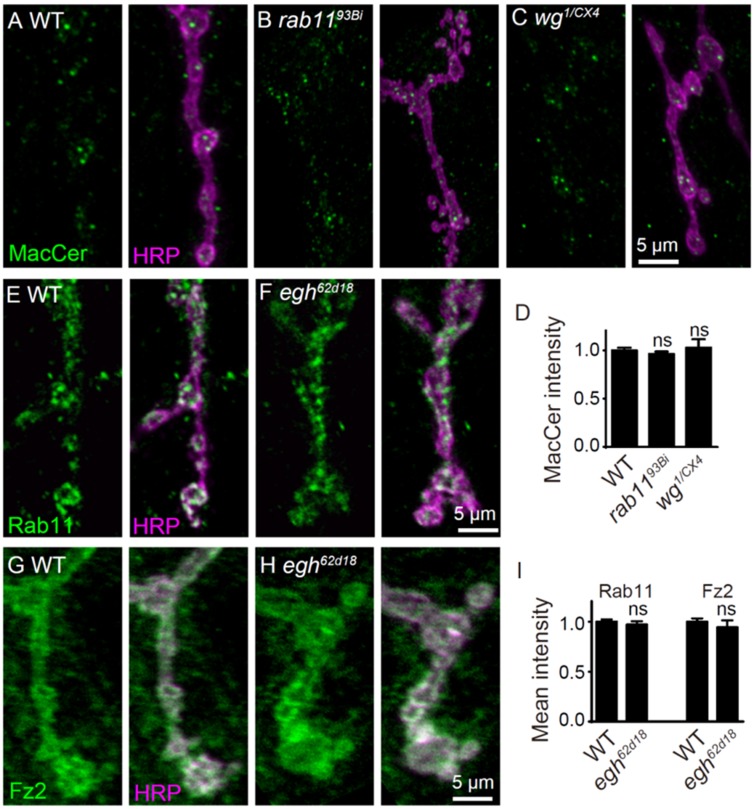
Images and quantifications of MacCer, Rab11, and Fz2 staining at NMJ of different genotypes.(A–C) Images of NMJ4 co-stained with anti-MacCer (green) and anti-HRP (magenta) in wild type (A), rab1193Bi (B) and wg1/wgCX4 (C). (D) Quantification of MacCer intensity normalized to HRP intensity in different genotypes. n ≥ 12 larvae; ns, no significance by student’s t test; error bars: s.e.m. (E–H) Images of NMJ4 co-stained with anti-Rab11 or anti-Fz2 (green) and anti-HRP (magenta) in wild type and egh62d18 mutants. (I) Quantification of synaptic intensities of Rab11 and Fz2 normalized to HRP intensities in different genotypes. n ≥ 12 larvae; p>0.05 by student’s t test; error bars: s.e.m.